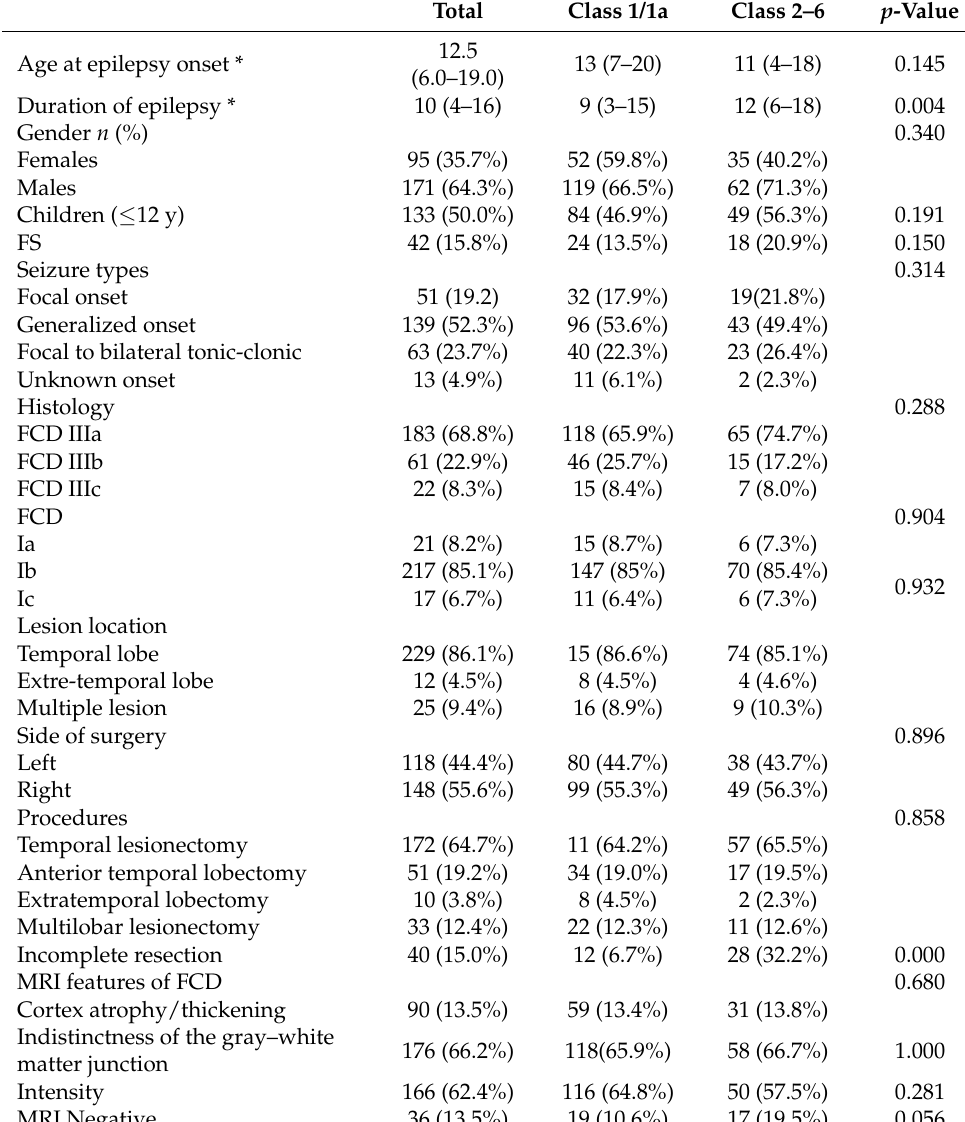
Table 1. Demographic Date for 266 Patients.